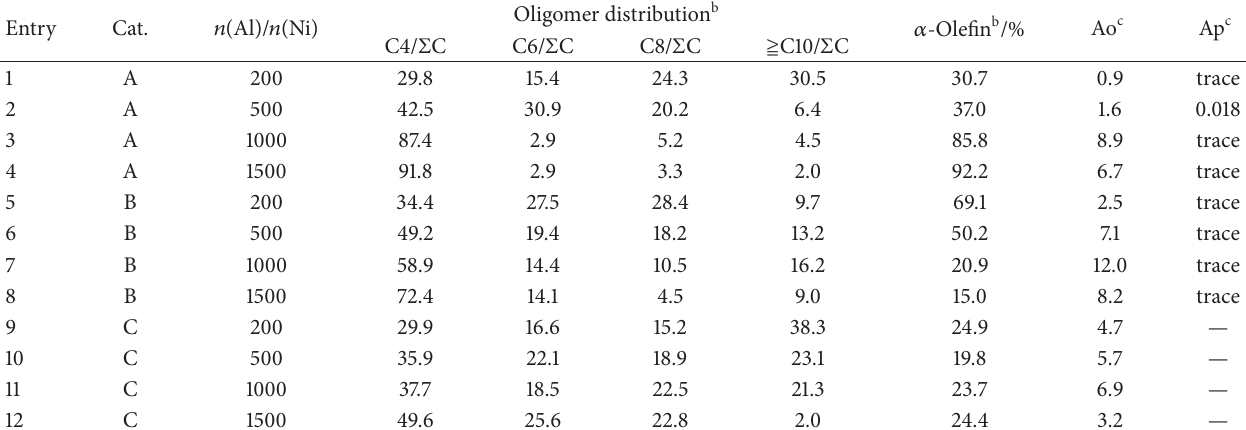
Table 1: Effects of 𝑛 (Al)/ 𝑛 (Ni) on the activity and distribution of oligomer a .